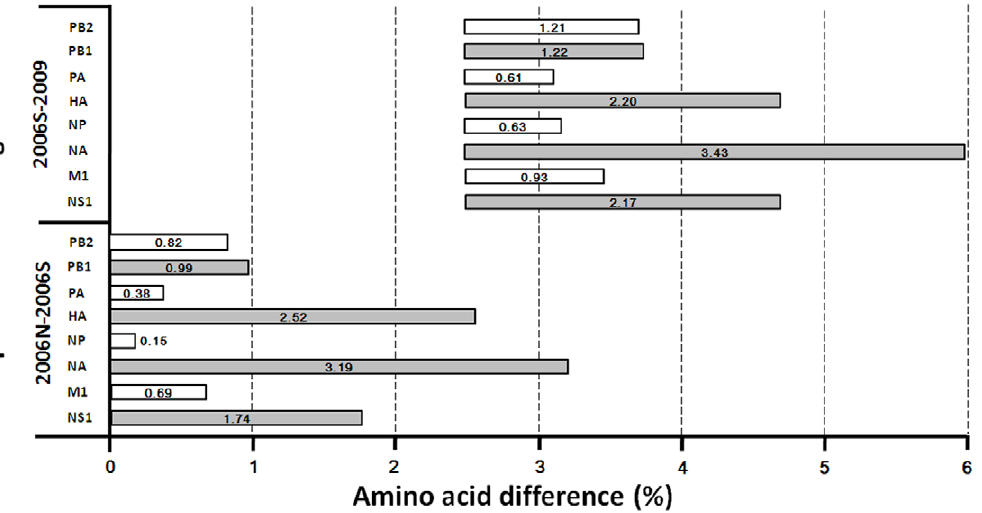
Figure 6. The trend of H1N1 protein distance. Distance means were computed as the arithmetic mean of all pair wise distances between two lineages. 2009 represents the circulating strain in 2009 which belong to A/Brisbane/59/2007-like lineage. 2006S represents the circulating strain in 2006 which belong to A/Solomon Island/3/2006-like lineage. 2006N represents the circulating strain in 2006 which belong to A/New Caledonia/20/ 1999-like